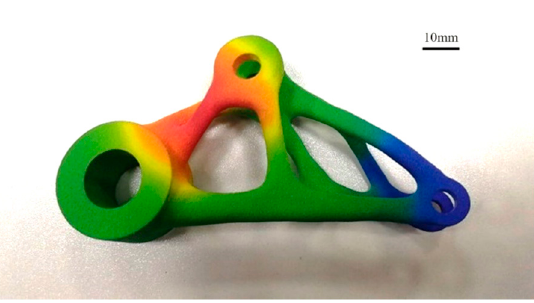
Figure 10. HP printed color Figure 10 . HP printed color part .